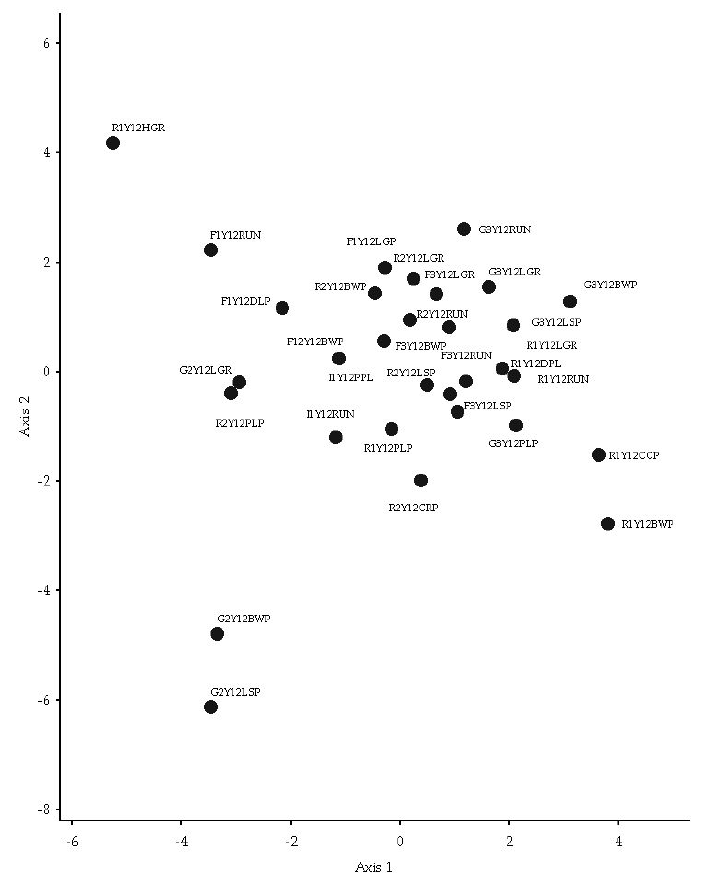
Figure 3. Principal component analysis of the 33 Basin Area Stream Survey parameters for the 9-land use/cover stations in the Neponset River watershed (Axis 1 (17.42% of variation) vs Axis 2 (14.58% of variation)). Axis 1 is negatively correlated with LEN, BFW, WAWID, DEP25, BTMC, ICSWD, ICTV, ICCLN LFTS, LFTVV, RGTS, RGTTV and positively correlated with MIDC, BTMS, and ICUCB. Axis 2 is negatively correlated with THAL, DEP25, DEP50, DEP75, ICTV, BTMS, and BTMF and positively correlated with BTMC, ICEMB, ICBO, ICCLN, RGTBK, RGTS (F = Forested (F1 and F3); G = Golf (G2 and G3), I = Industrial (I1 and I3); R = Residential (R1 and R3); Y10 = 2010; Y12 = 2012). Basin Area Stream Survey acronym definitions are located in Table A1.